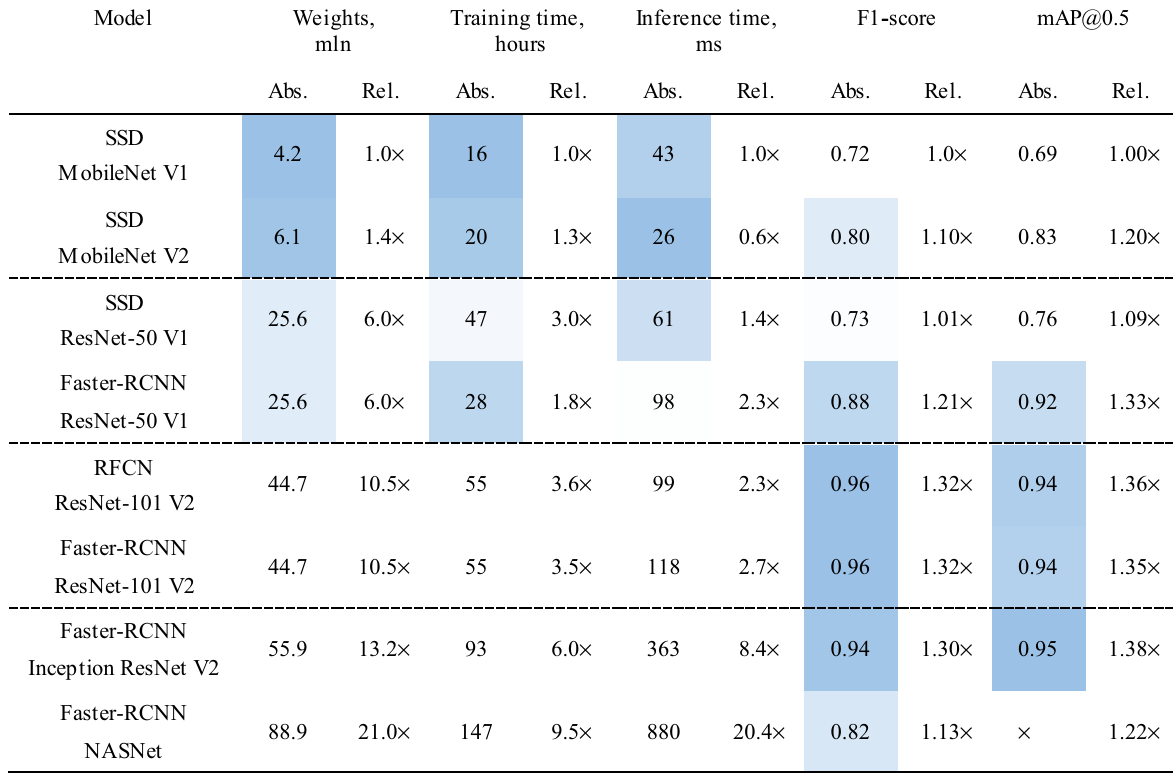
Table 4. Comparative study of the selected models.